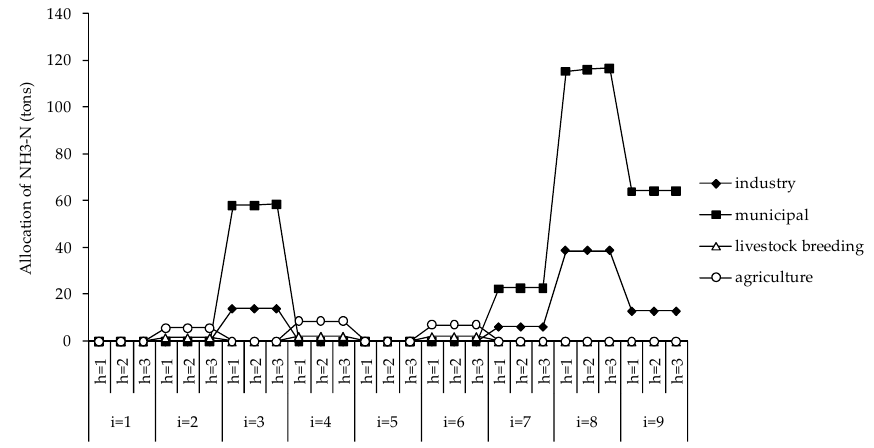
Figure 6. Allocation amounts of the controlled pollutants in Period 3.